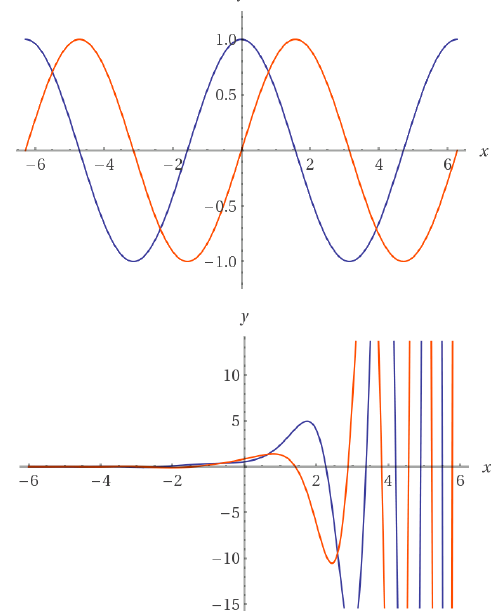
Figure 4. The root functions for the standard NLSE and the inhomogenous variable coefficient NLSE. ( Top ) The seed impulse used in the solutions to the standard NLSE, e ix [19]. ( Bottom ) A generic form of the seed impulse used in the solutions of the inhomogenous variable coefficient NLSE [17] f ( x ) = e i ( 1 − x 2 /2 )+ x . Real part (blue) and imaginary part